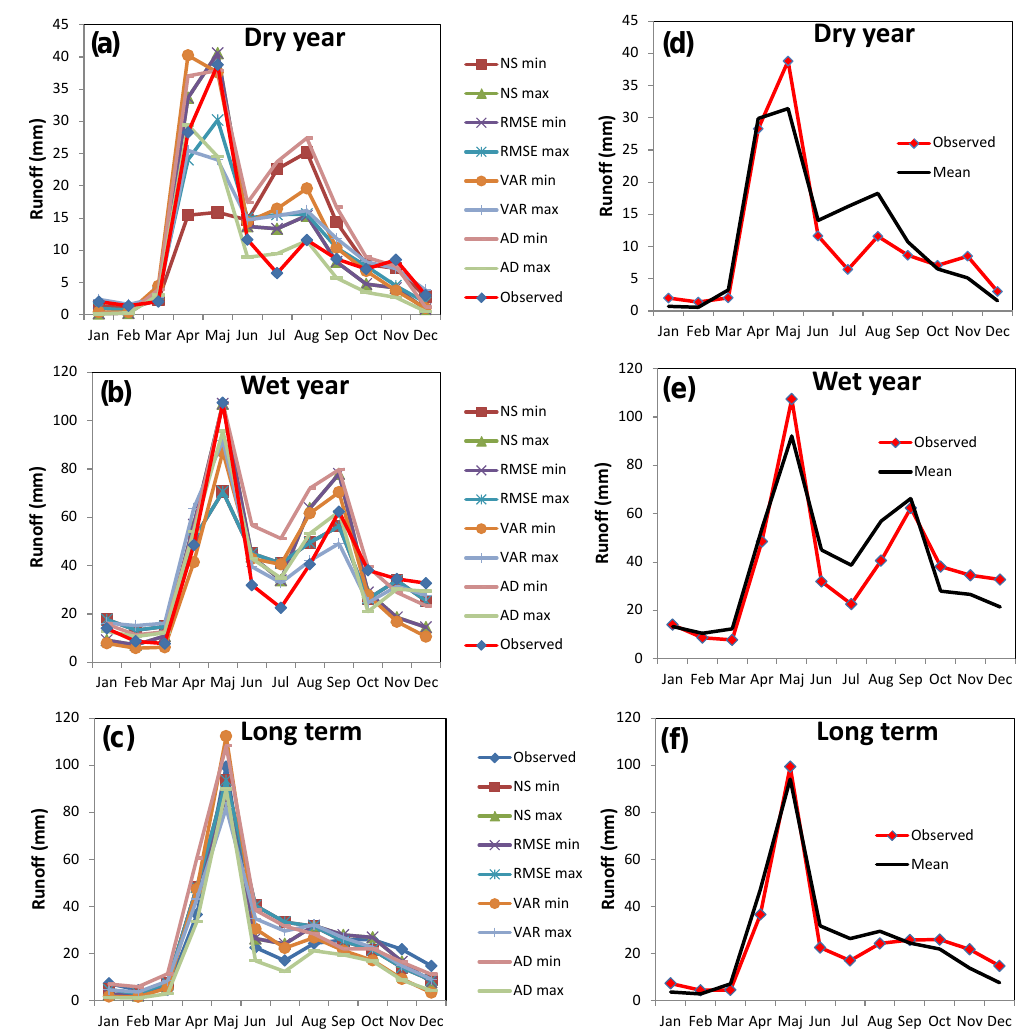
Figure 5. Summary plots showing the prediction ranges of seasonal runoff dynamics of behavioural parameter sets using different per- formance metrics in (a) dry years, (b) wet years and the (c) long term. (d) to (f) show the corresponding model performances using the behavioural means of the metrics in (a) to (c)